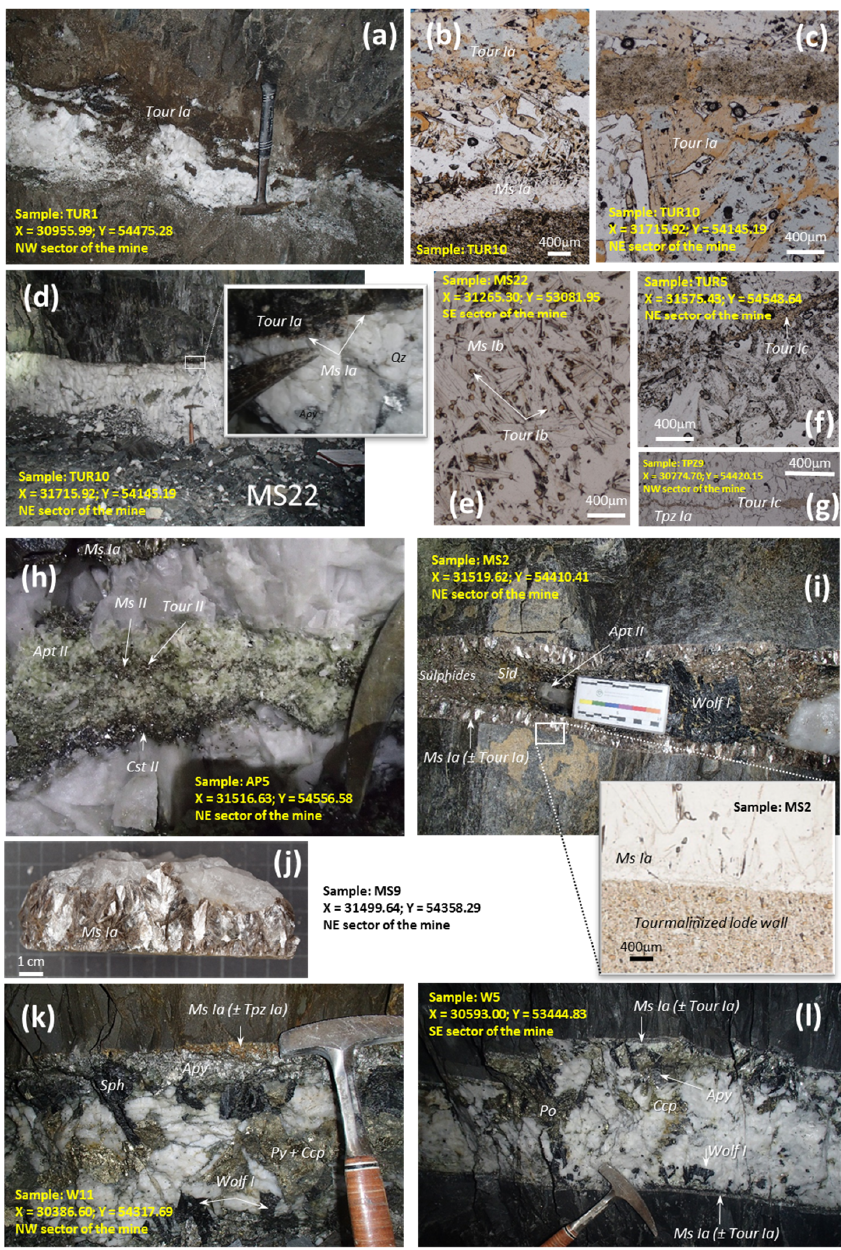
Figure 4. ( a ) Photograph of the quartz lode wherein the sample TUR1 was collected, illustrating a situation of strong tourmalinization of wall rocks and incorporation of metasediment slivers that are also enriched in Tour Ia . ( b , c ) Photomicrographs (transmitted microscopy, plane-polarized light–TM/PPL) of a tourmalinized wall contacting a lode border decorated by coarse-grained Tour Ia (adjoining a Ms Ia thin selvage); note the late development a “dissolution band” affecting Tour Ia . ( d ) Photograph of the quartz lode wherein the TUR10 sample was collected. ( e ) Photomicrograph (TM/PPL) documenting a fine-grained and non-oriented Ms Ib aggregate wherein Tour Ib is disseminated. ( f , g ) Tour Ic infillings of microfractures crossing over Ms Ia (± Qz ) and Tpz Ia aggregates at the lode borders, respectively. ( h ) Photograph of the quartz lode wherein the AP5 sample was collected, illustrating a late reopening of the lode that allowed a confined deposition of Tour II (as needles), Apt II , Ms II and Cst II . ( i , j ) Ms Ia thick borders of quartz lodes, often contacting tourmalinized walls. ( k ) Photograph of the quartz lode wherein the W11 sample was collected; coarse-grained Ms Ia (± Tpz Ia ) in lode walls. ( l ) Photograph of the quartz lode wherein the W5 sample was collected; coarse-grained Ms Ia in thinner selvages along with accessory Tour Ia .